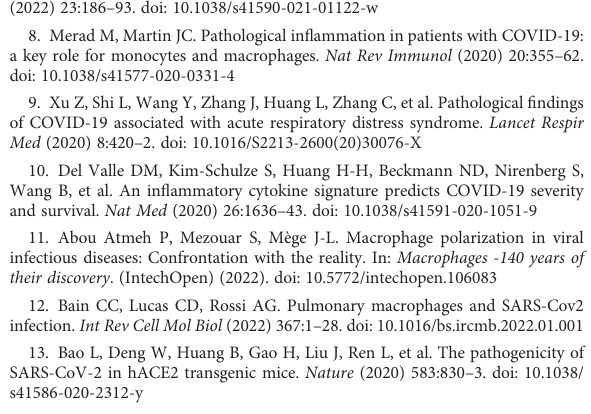
SUPPLEMENTARY FIGURE 1 Vero E6 cell line infection with SARS-CoV-2 variants Vero E6 cells were infected with SARS-CoV-2 variants including Wuhan (China), a -B.1.1.7 (United Kingdom, UK), b -B.1.351 (South Africa, SA), g -P.1 (Brazil), d -B.1.617 (India) and B.1.1.529 (Omicron) (0.1 MOI) for 6, 24, 48 or 72 hours. (A) Cell viabilitywastestedat24,48and72hourspost-infection. (B) Thepresence of SARS-CoV-2 was evaluated and quanti fi ed by immuno fl uorescence (left panel, virus in green, nucleus in blue and F-actin in purple) and